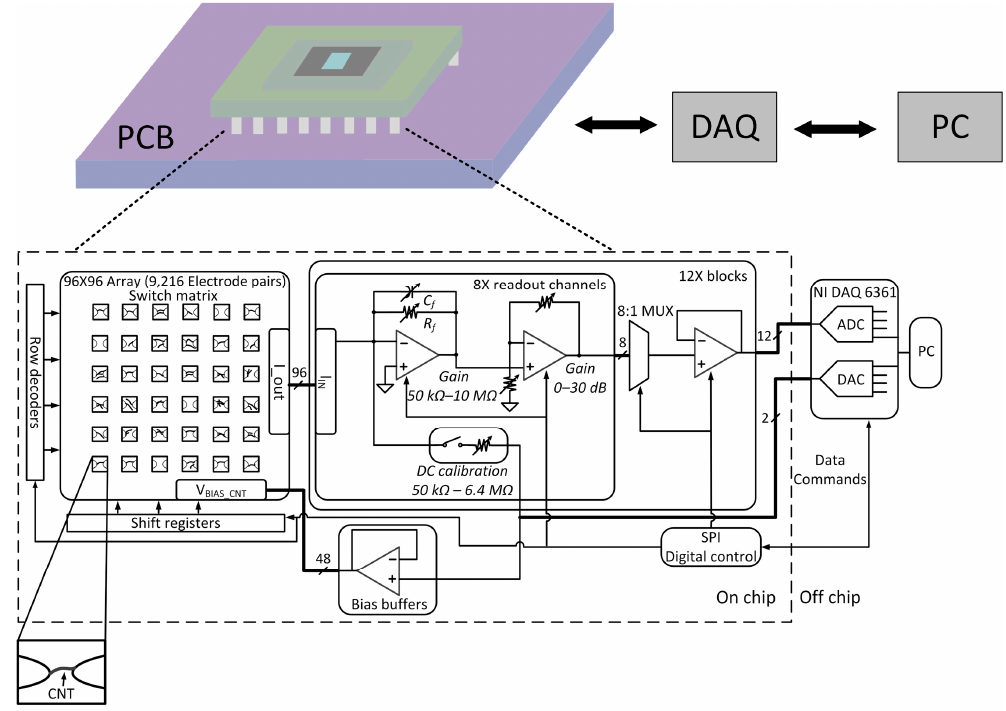
Figure 1. Block-diagram of the overall sensor system and setup (adapted from Reference [17]).